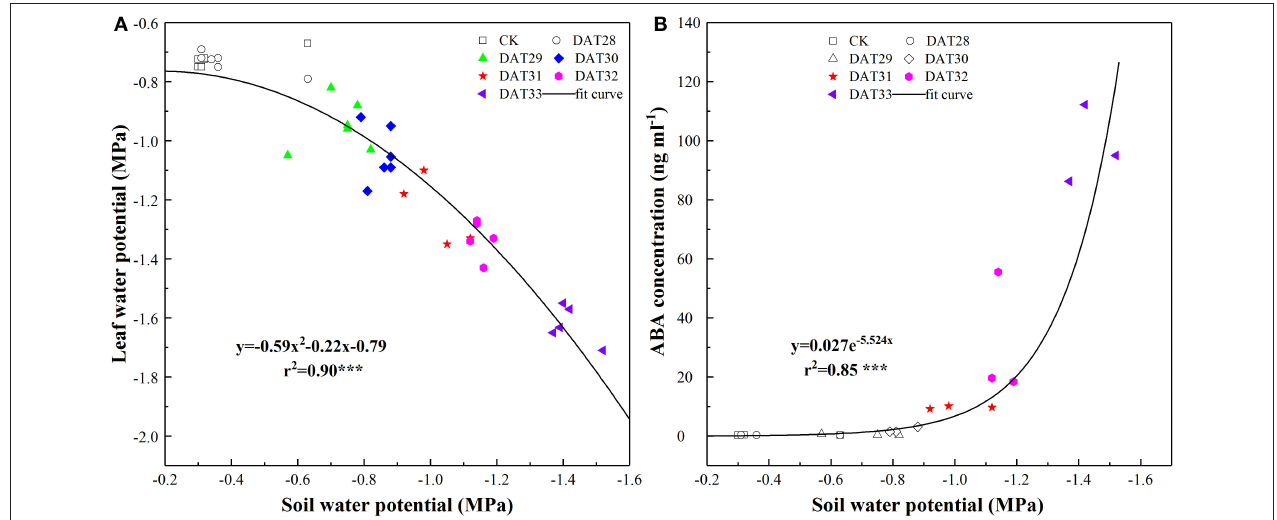
FIGURE 2 | Leaf water potential ( n = 6) (A) and shoot sap ABA concentration ( n = 3) (B) in response to progressive soil water potential decrease. Colorful labels indicated significant difference at P < 0.001 level between well-watered and drought treatment.